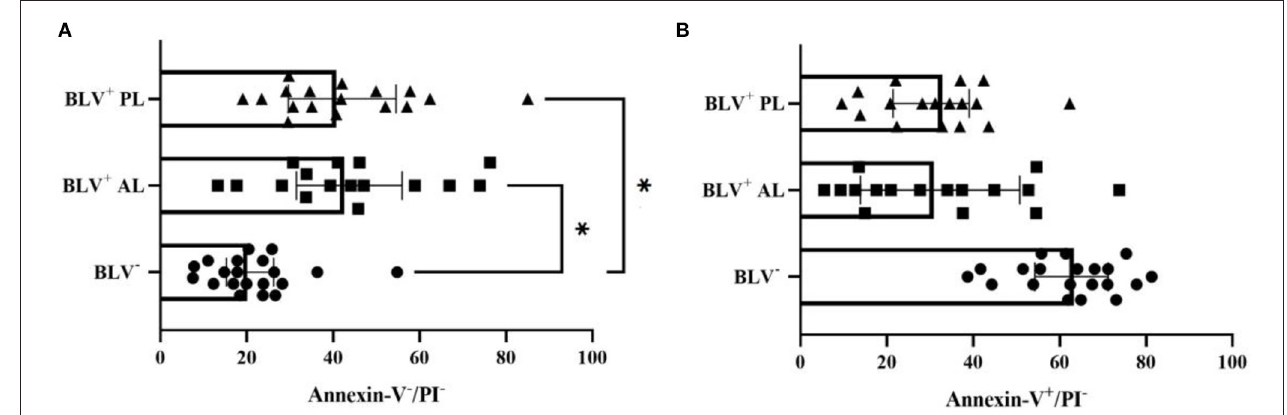
FIGURE 2 | Percentage (individual values and median ± interquartile range) of viable (Annexin-V − /PI − ) (A) and apoptotic (Annexin-V + /PI − ) (B) milk macrophages from health mammary glands in bovine leukemia virus (BLV) seronegative (BLV − ) and in BLV-infected (BLV + ) dairy cows without (AL) and with persistent lymphocytosis (PL). * P <